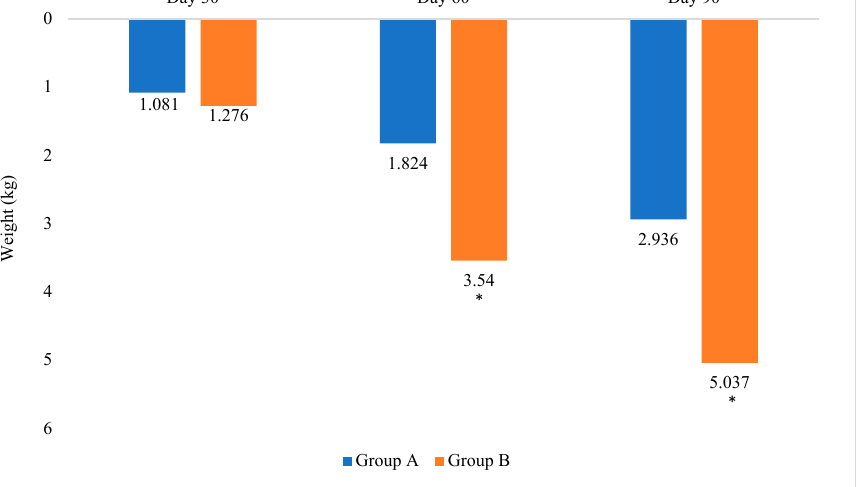
Figure 1. Change in weight (%) from the baseline. * p value significant depicting the comparison between Groups A and B. Group B lost approximately 1.7 times more weight than Group A at the end of 90 days, compared with the baseline.